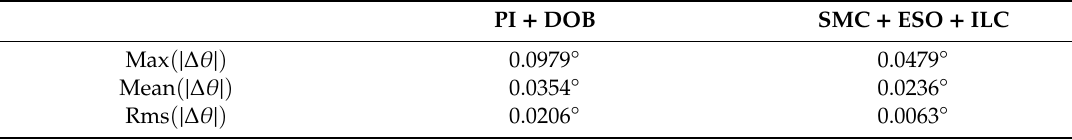
Table 7. Position pointing error of triangular wave